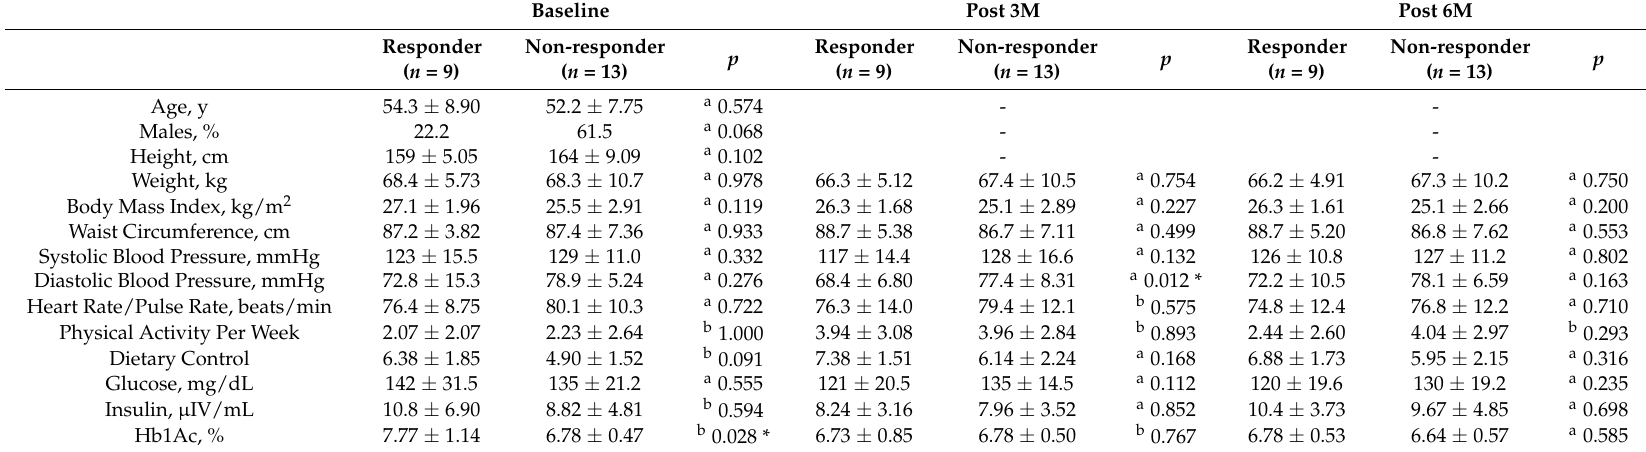
Table 1. Characteristics of responder and non-responder groups at baseline, and after 3 months (Post 3M) and 6 months (Post 6M) of metformin administration ( n =